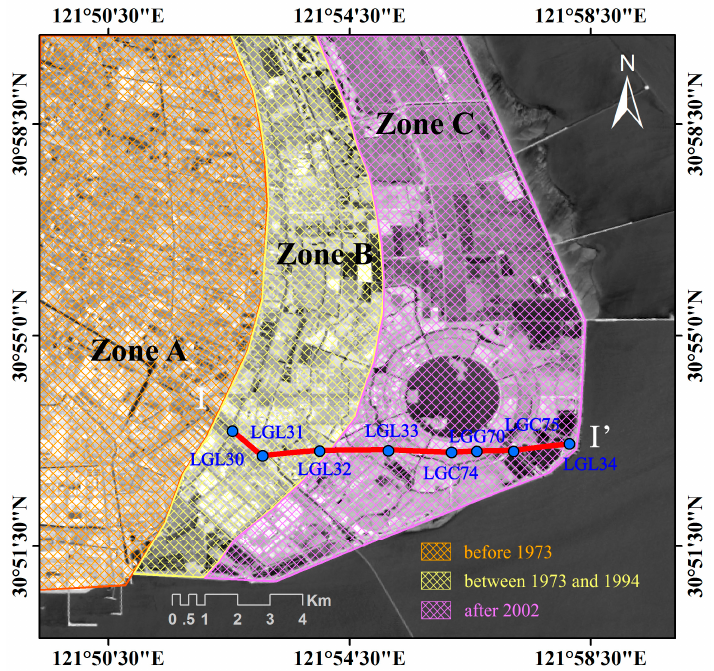
Figure 9. Lingang New City. Map of three ocean-reclaimed zones and the location of eight boreholes (blue circles) along the profile (red line) from I to I’ considered for the presented analyses.